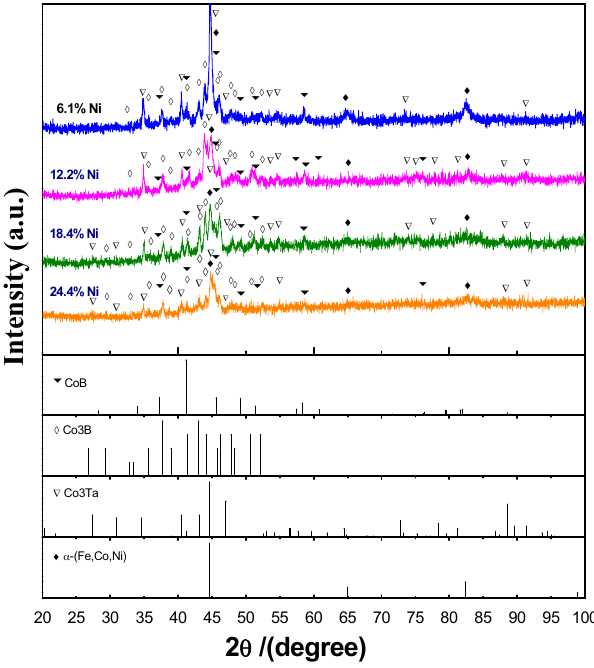
Figure 2. X ‐ ray diffraction patterns with different Ni contents.